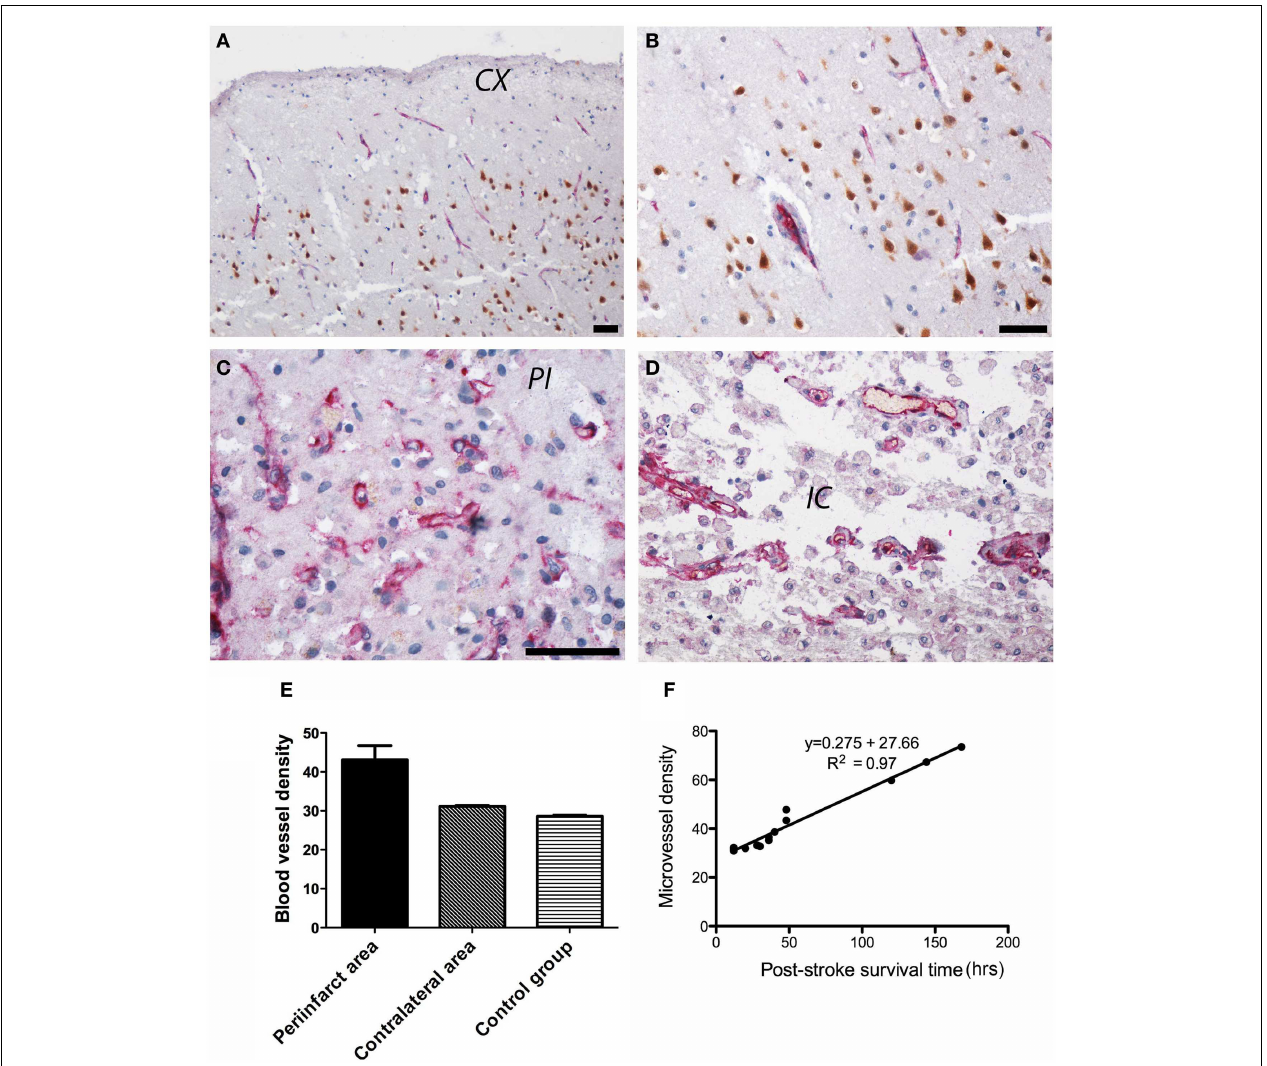
present in the endothelium of spared blood vessels. (E) Quantitatively, the highest vascular density (given as number of microvessels/0.7386mm 2 ) was in the peri-infarcted area as compared to the contralateral side and the control group. (F) We also noted a strong correlation between post-stroke angiogenesis and post-stroke survival time [ r (13) = 0.984, p < 0.001]. CX, cortex; PI, peri-infarct; IC, infarct core. Bars, 50 µ